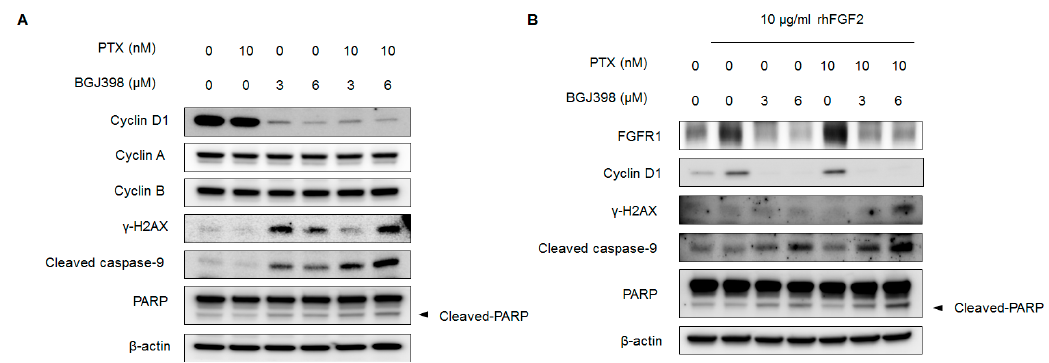
Figure 4. PTX and BGJ398 synergistically inhibit cyclin D1 expression and stimulate apoptosis-associated proteins in J82 cell line. ( A ) Cells were treated with indicated concentration of PTX and BGJ398 for 24 h. Expression of cyclin D1 , cyclin A , cyclin B , γ -H2AX , caspase-9 , PARP , and β -actin (loading control) was analyzed by Western blotting. ( B ) FGFR signaling was activated with 10 μ g/mL rhFGF2 for 3 h prior to treatment with indicated concentrations of PTX and BGJ398. 2.4. PTX Combined with BGJ398 Reduces the Migratory Capacity of Mesenchymal-Type UC Cells